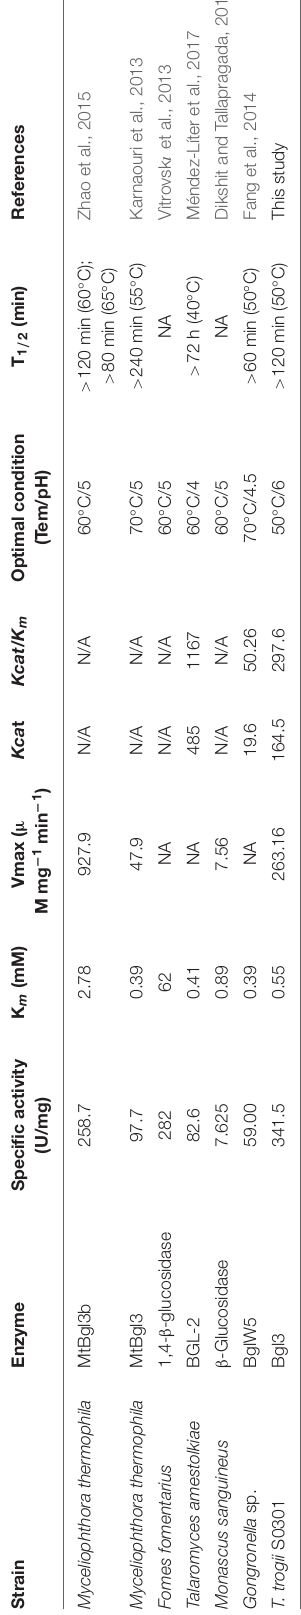
TtBgl3 was stable at a wide range of pH from 5.0 to 10.0 with more than 95% of maximum activity after 2 h of treatment ( Figure 3C ). TtBgl3 retained 90% of their initial activity after 5 h incubation at 50 ◦ C ( Figure 3D ). However, β -glucosidase activity decreased rapidly at temperatures above 60 ◦ C ( Figure 3 ). The specific activity, K m , V max , and K cat values of TtBgl3 for p NPG at 50 ◦ C and pH 5.5 were determined to be 341.5 U/mg, 0.55 mM, 263.16 µ M/mg/min, and 164.5, respectively ( Table 1 ). Catalytic